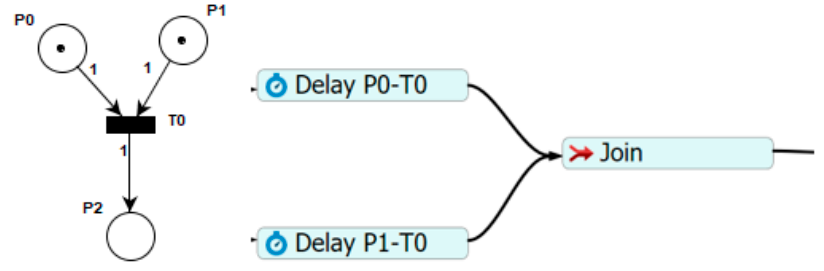
Figure 11. Synchronization with temporal entities in FlexSim.